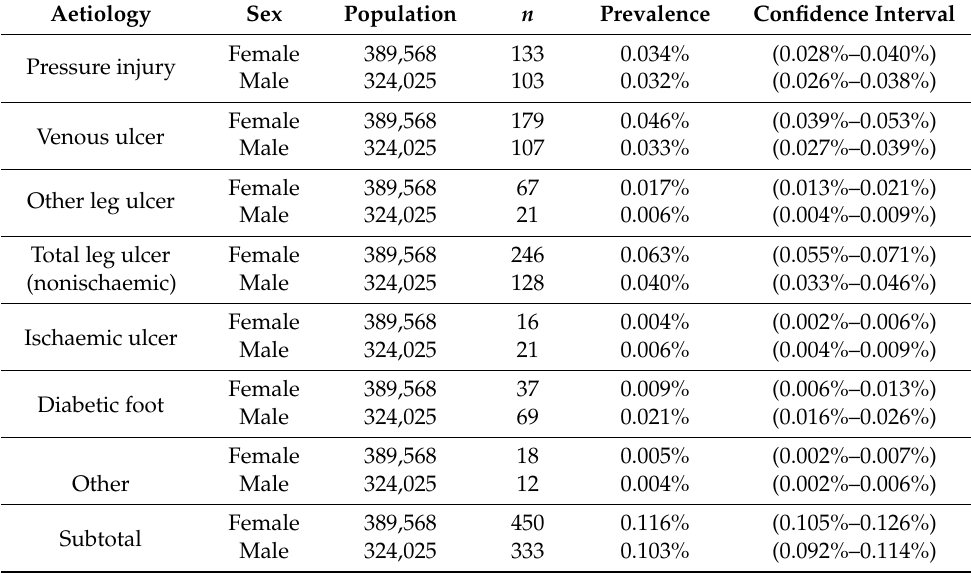
Table 3. Prevalence of chronic wounds. Adjusted by